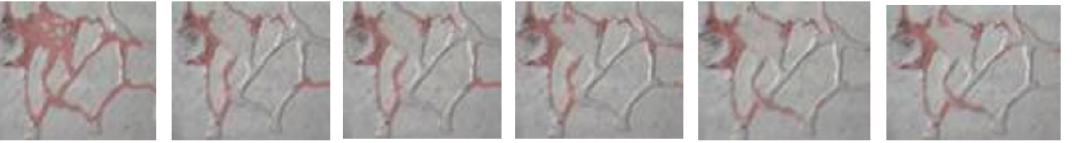
Figure 12. Variation of remaining contiguous oil in the same area with different displacement rates (the time from left to right was 729 s, 1160, 1500, 1990, 2300, and 2633 s). When the displacement rate increases from 0.05 mL/min (when the cumulative PV number is 5.1) to 0.1 mL/min (when the cumulative PV number is 11.2), it can be seen that